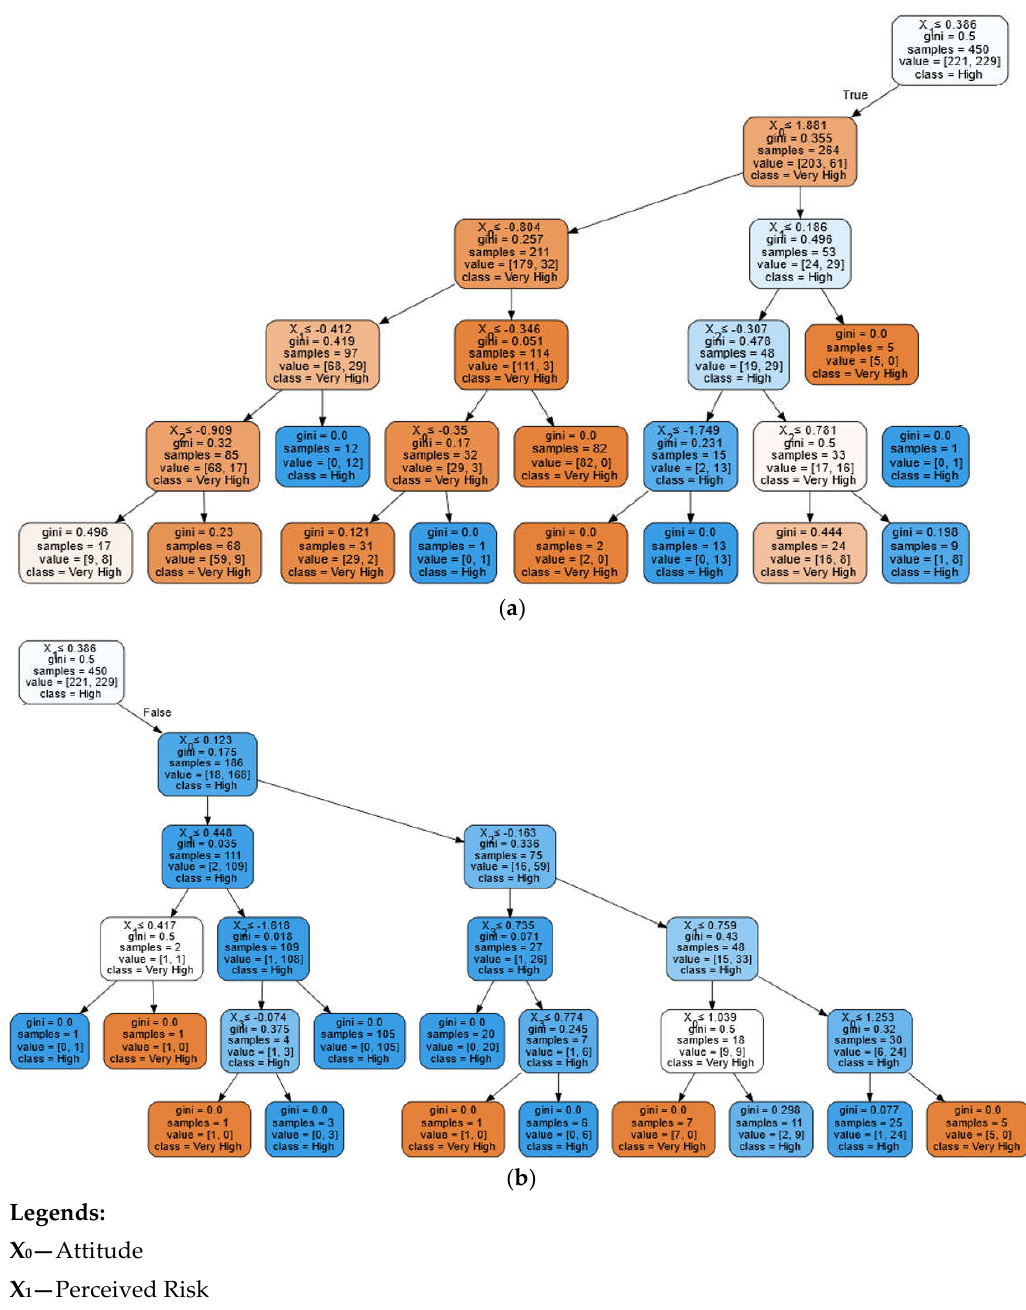
Figure 3. ( a ) . Optimum Tree with Random Forest Classifier (True side). ( b ) . Optimum Tree with Random Forest Classifier (False side).